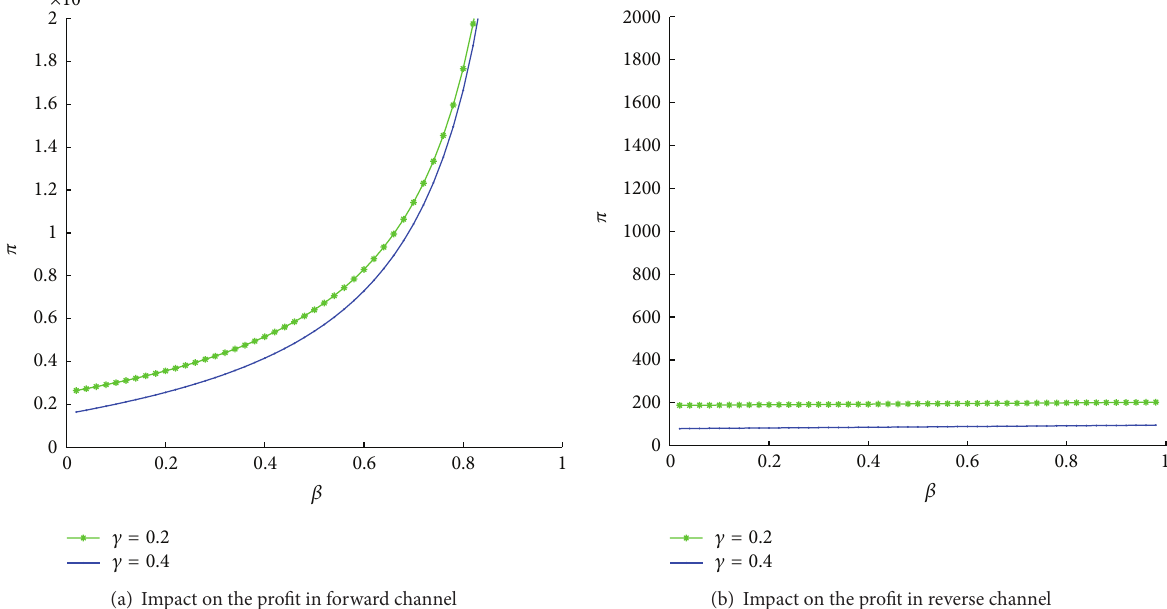
Figure 3: Impact of the retailing and recycling substitution effects on channel profit in model 𝐶 .